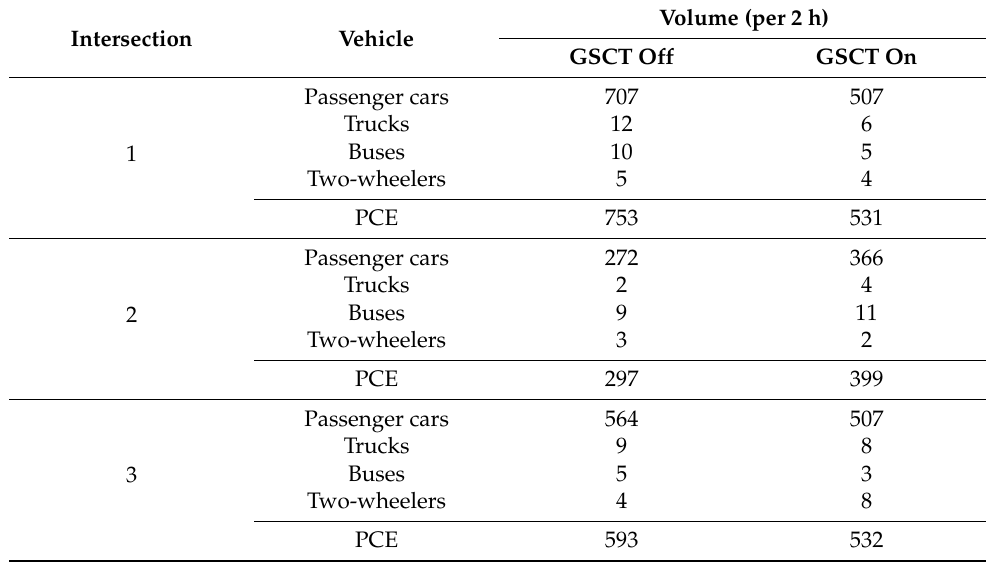
Table 2. The volume of vehicles on intersections during the measurement period (2